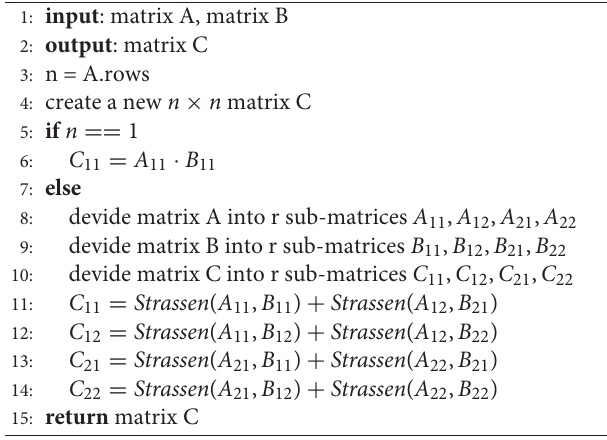
Algorithm 2: Matrix multiplication algorithm. Algorithm 3: Strassen